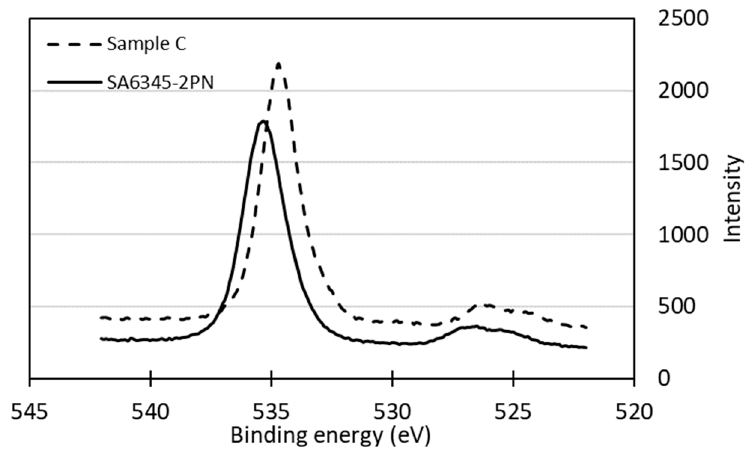
Figure 16. XPS spectrum of O1s in “SA6345-2PN” and sample C.